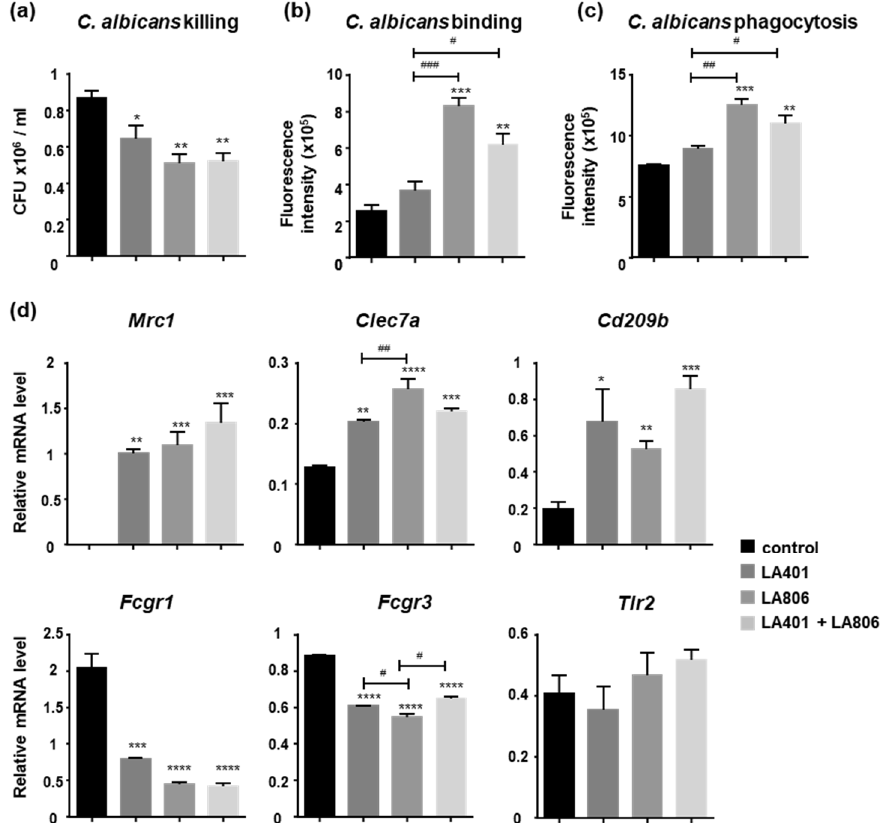
Figure 4. In vitro modulation of the anti-fungal activity of macrophages by Lactobacillus helveticus LA401 and/or Lactobacillus gasseri LA806. ( a ) Killing assay of murine peritoneal macrophages treated or not with LA401 and LA806 alone or in combination incubated with Candida albicans . ( b ) Binding and ( c ) phagocytosis of C. albicans by murine peritoneal macrophages treated or not with LA401 and LA806 alone or in combination. ( d ) Gene expression analysis of Pattern Recognition Receptors by IFN- γ and LPS-activated macrophages in response to probiotic treatment ( Mrc1 , Clec7a , Cd209b , Tlr2 ) and Fc γ receptors ( Fcgr1 , Fcgr3 ). Results are represented as means ± SEM of triplicates. * p ≤ 0.05, ** p ≤ 0.01, *** p ≤ 0.005, **** p ≤ 0.001 compared to control. # p ≤ 0.05, ## p ≤ 0.01, ### p ≤ 0.005 compared to